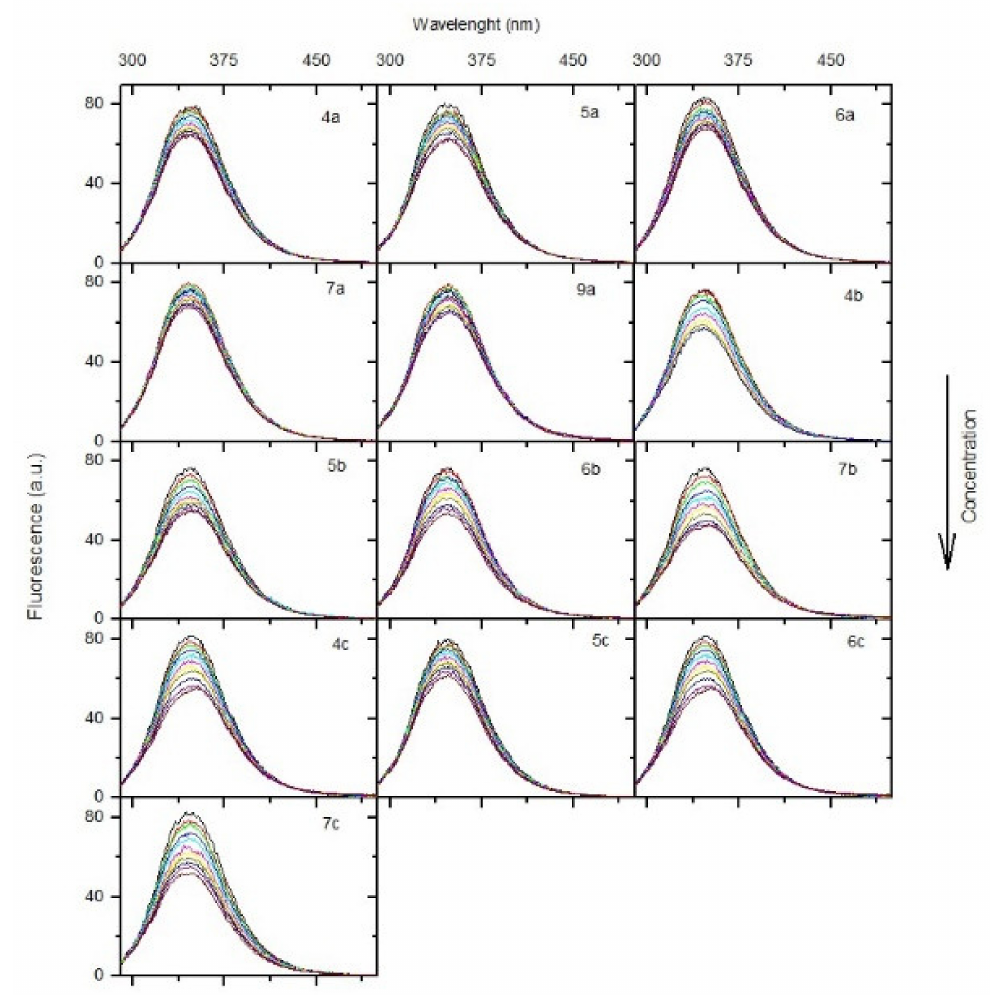
Figure 9. Fluorescence spectra of BSA solution in the presence of studied compounds (T-297 K, λ ex = 280 nm). The concentration of derivatives from series a, b and c increased gradually as follows: 0, 0.2, 0.4, 0.6, 0.8, 1.0, 1.2, 1.4, 1.6, 1.8, 2.0 µ